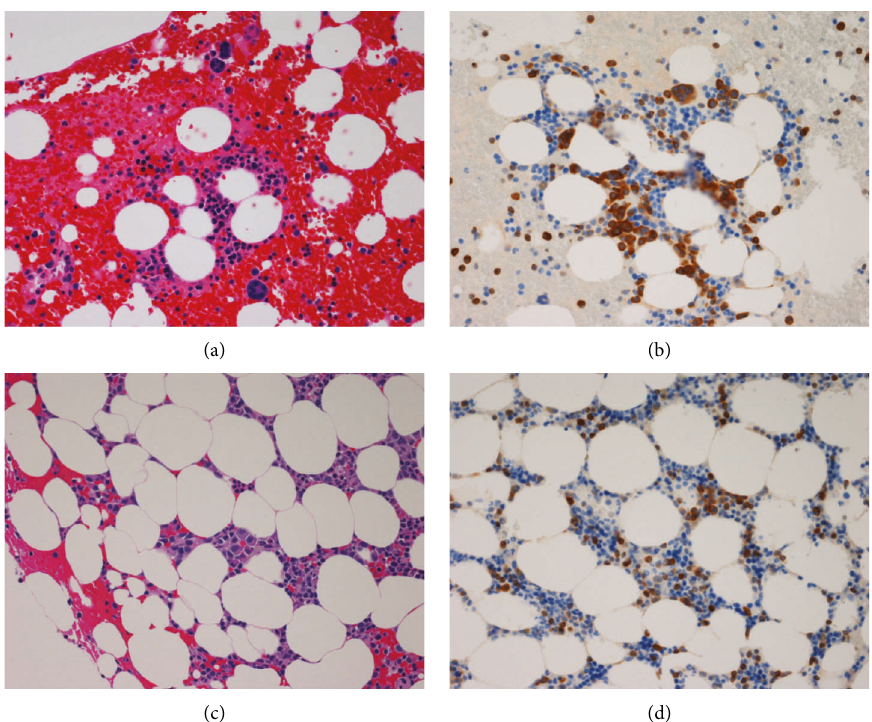
Figure 2: Bone marrow specimens in 2021: (a) atypical plasma cells with lymphocytes ( × 20). (b) Both lymphocytes and plasma cells are BCL2-positive ( × 20). Bone marrow specimens in 2016: (c) lymphocytes and plasma cells are observed ( × 20). (d) Plasma cells. Both cells and lymphocytes are BCL2-positive ( ×